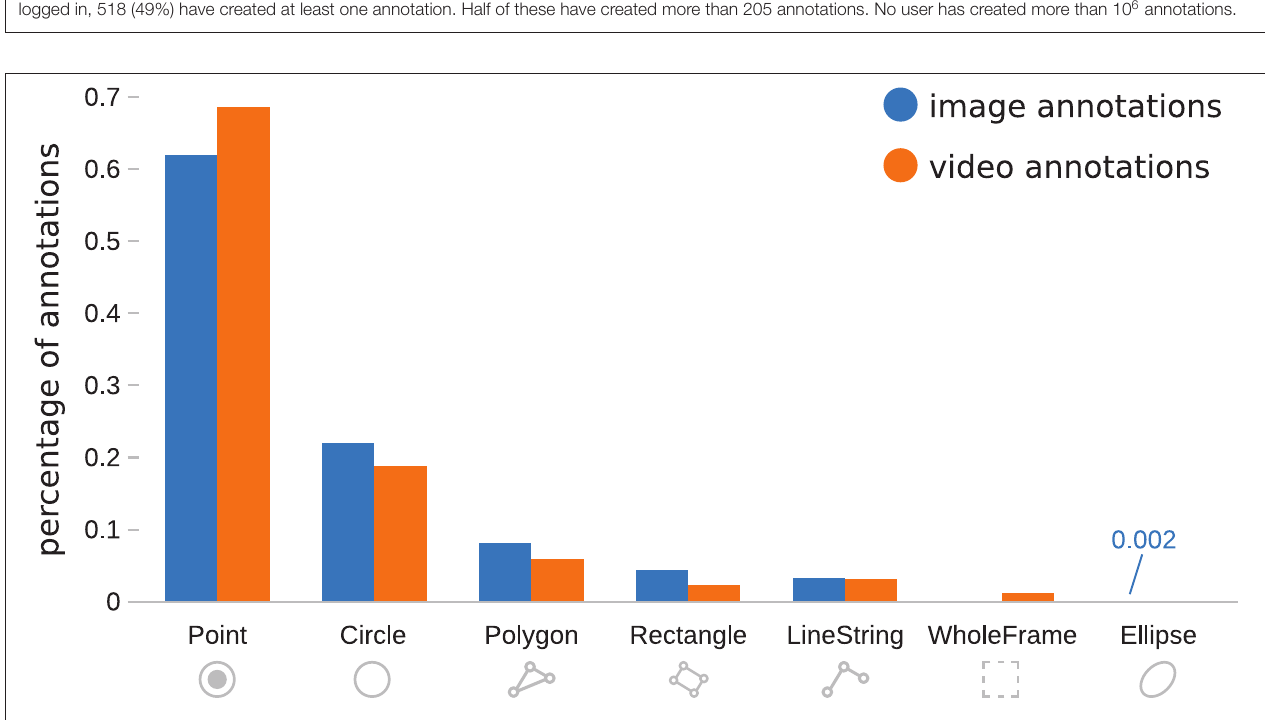
FIGURE 7 | Comparison of the percentage of annotation shapes used for image annotations and video annotations. The WholeFrame shape is only available for video annotations and the Ellipse shape is only available for image annotations. Image annotations for laser points or created by using MAIA (see Section 2.3) are excluded. The vast majority of annotations have the Point